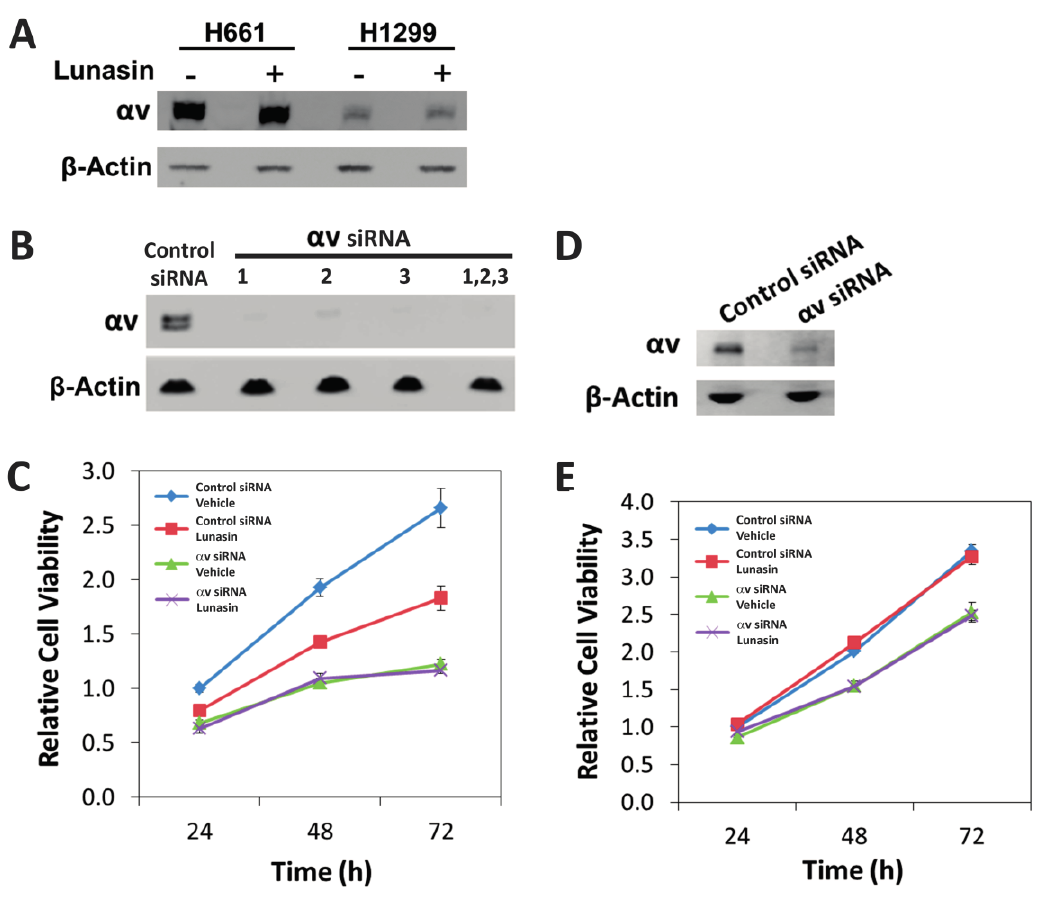
Figure 7. Effects of silencing the α v integrin subunit in NSCLC H661and H1299 cells. ( A ) Immunoblot analyses of α v subunit levels in H661 and H1299 cells treated with either vehicle or lunasin. Cells were treated for 24 h with 100 µM lunasin or 50 mM NaPO 4 , pH 7.4; ( B ) Immunoblot analysis of α v expression in H661 cells transfected with a control siRNA or three different siRNAs designed to silence α v expression individually or in combination. β -actin was used as a loading control; ( C ) Proliferation of control siRNA transfected H661 cells and H661 cells transfected with a combination of three α v-specific siRNAs; ( D ) Immunoblot analysis of α v expression in H1299 cells transfected with a combination of three α v-specific siRNAs; ( E ) Proliferation of control siRNA transfected H1299 cells and H1299 cells transfected with a combination of three α v-specific siRNAs. Proliferation assays were initiated 48 h after transfection with siRNAs; cells were treated with either 50 mM NaPO 4 , pH 7.4 (vehicle) or 100 µM lunasin. Data shown are the mean ± SD obtained in three independent